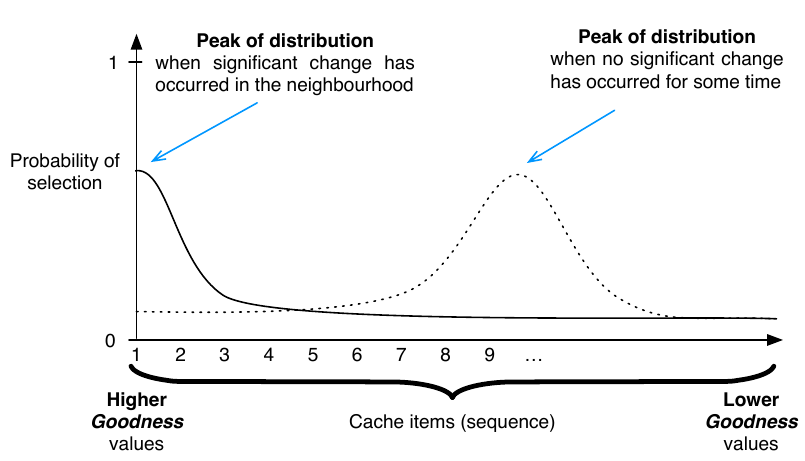
Figure 5. Data selection mechanism in K EETCHI